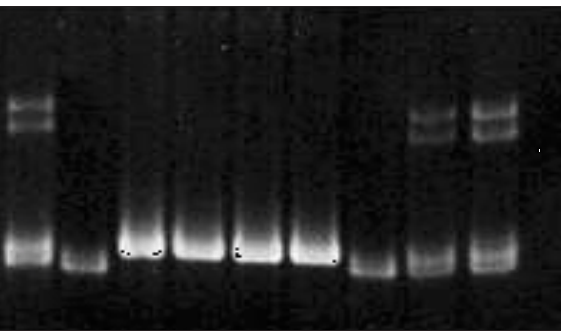
Figura – Gel de poliacrilamida corado com brometo de etídio mostrando oito neonatos rastreados pelo teste de IRT. Da esquerda para a direita: poços 2 e 7